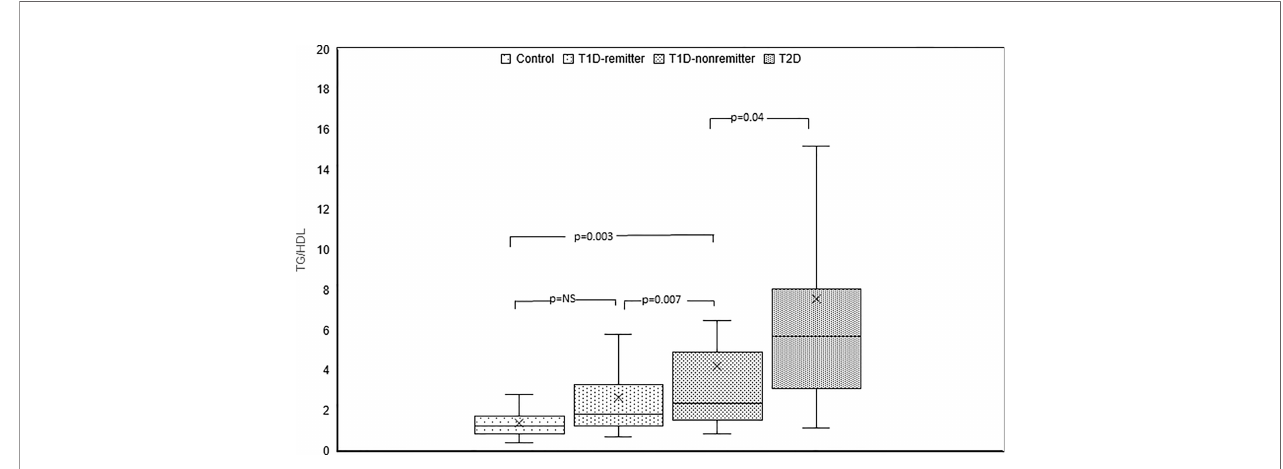
FIGURE 7 | Box plots of early post-diagnostic patterns of triglycerides/high-density lipoprotein cholesterol ratio (TG/HDL) in the remitters, non-remitters, and subjects with type 2 diabetes (T2D) compared to controls (5).